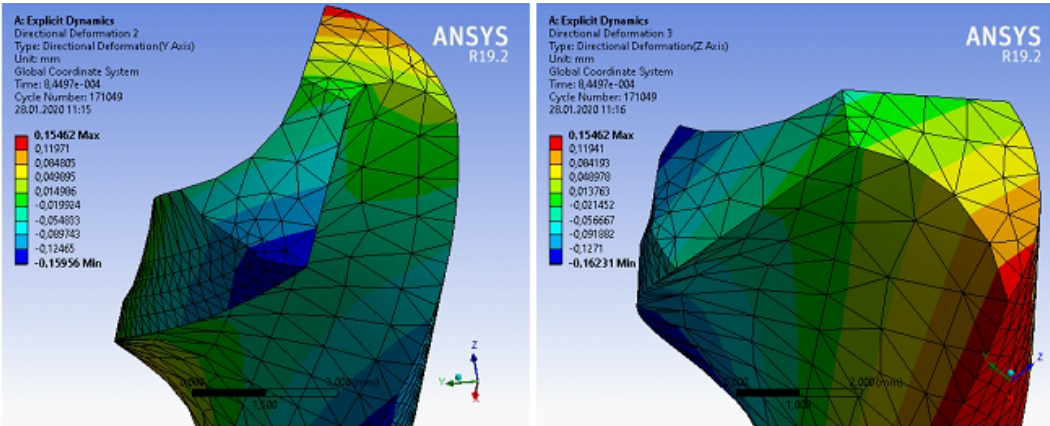
Figure 34. Ansys y -axis and z -axis directional deformation